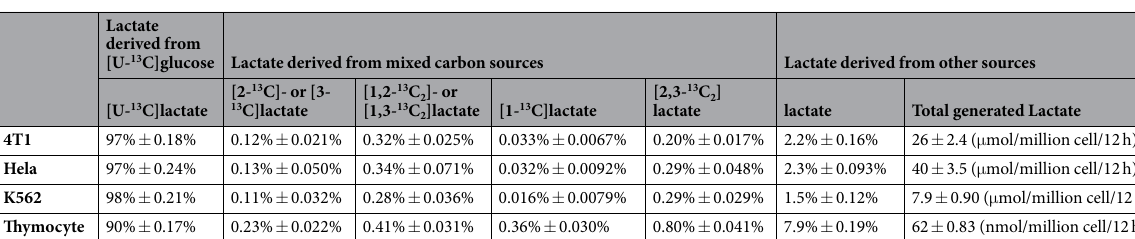
Table 1. The percentage of lactate isotopomers and isotopologues (mean ± SD, n = 12) generated by 4T1, Hela, K562, and thymocytes, traced by [U- 13 C]glucose. 4T1, Hela, K562 and thymocyte were incubated in serum-free RPMI 1640 medium containing 6 mM [U- 13 C]glucose for 12 hours in a humidified CO 2 incubator and culture supernatant was collected for LC-MS/MS analysis as described in Materials and Methods. Data are mean ± SD, n = 12, from 2 independent